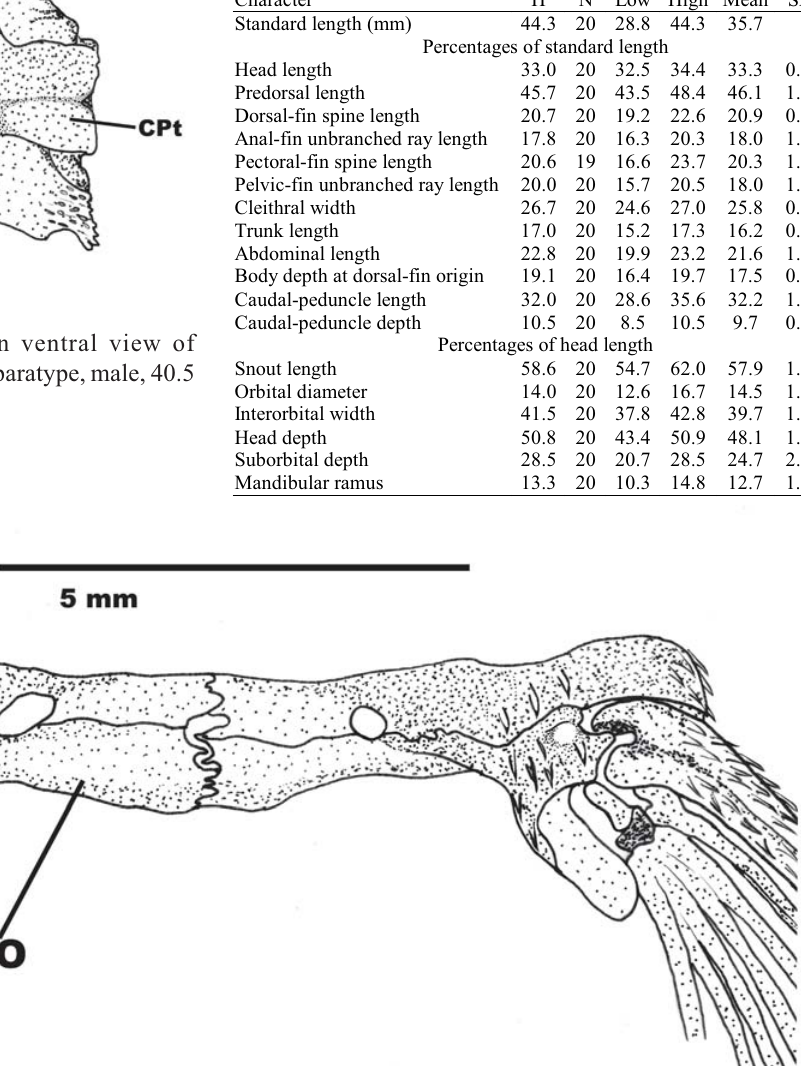
Table 1. Descriptive morphometrics of Gymnotocinclus anosteos . Values are given for holotype (H) and ranges of 20 specimens including the holotype. SD = standard